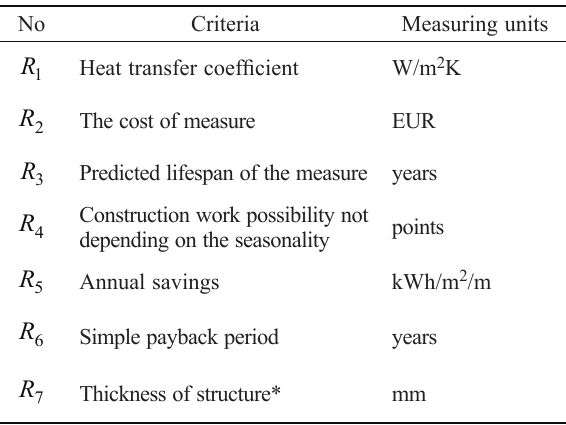
table 1. criteria set for analysis of alternative modernization